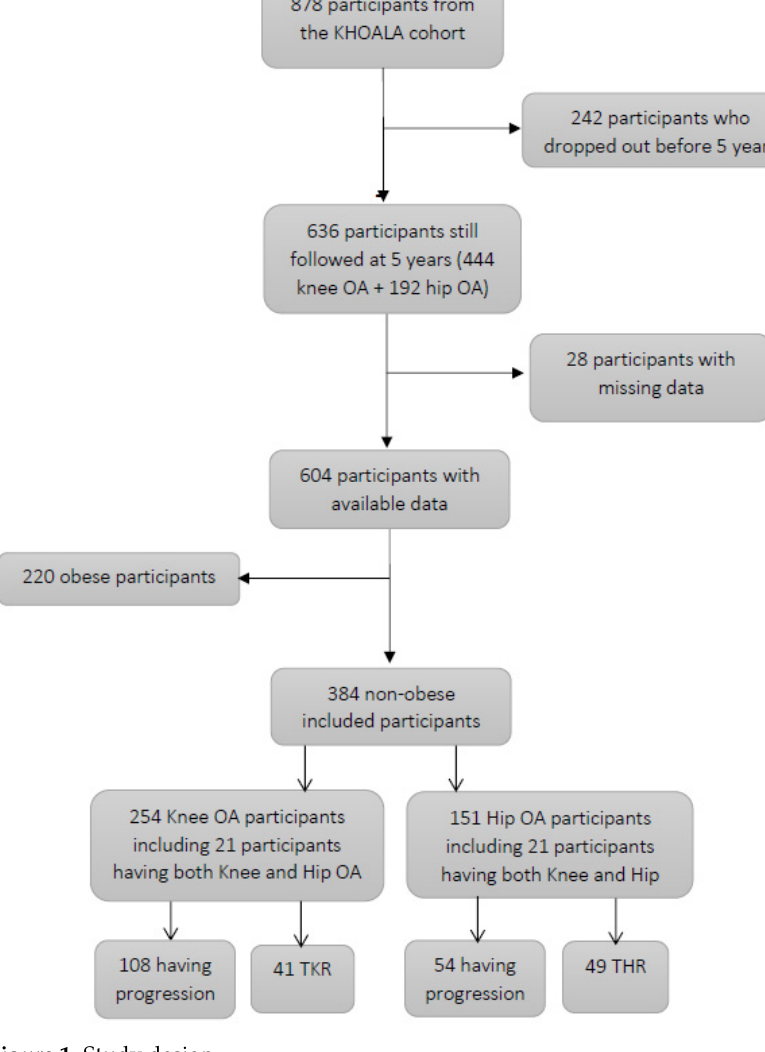
Figure 1. Study Figure 1. Study design.